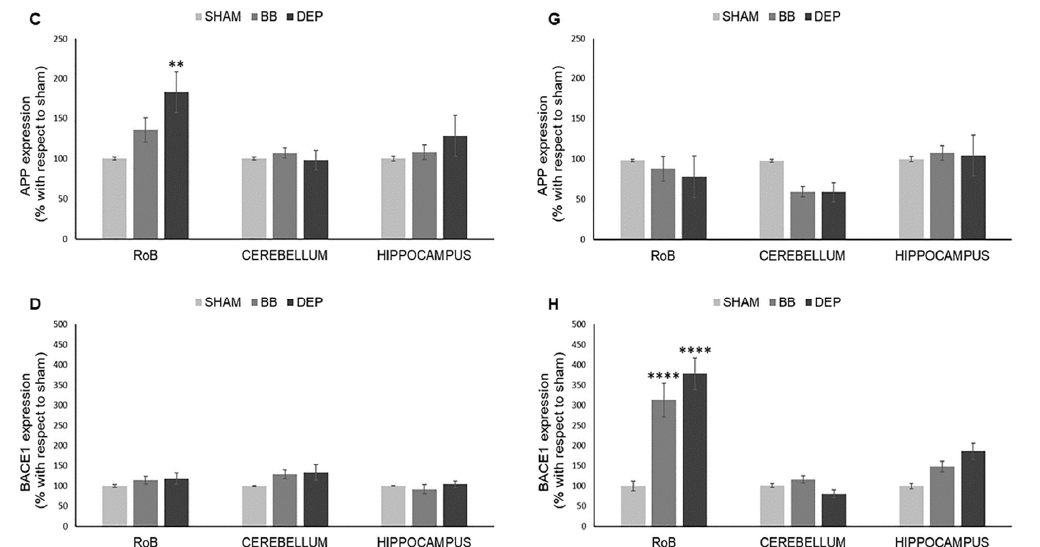
Figure 3. Amyloidogenic precursor protein (APP) processing analysis after single and repeated instillations of BB and DEP. Representative immunoblotting images of amyloid precursor protein (APP), phosphorylated APP on threonine 668 (p-APP Thr668 ), and beta-secretase 1 (BACE1) analysis in mice after single ( A ) and repeated ( E ) instillations with 50 μg of BB or DEP/100 μL 0.9% NaCl. Histograms display p-APP Thr668 /APP, APP, and BACE1 protein levels in mice after single ( B – D ) and repeated ( F – H ) instillations with BB and DEP, with respect to sham. Proteins are normalized to corresponding total proteins revealed by Ponceau in each lane (Figure S3, Supplementary Materials), and the data are expressed as means ± SEM ( n = 6). Statistical differences were tested accordingly by one-way ANOVA followed by Tukey post hoc comparison. ** p < 0.01 vs. sham mice; **** p < 0.0001 vs. sham mice; § p < 0.05 vs. BB-treated mice.